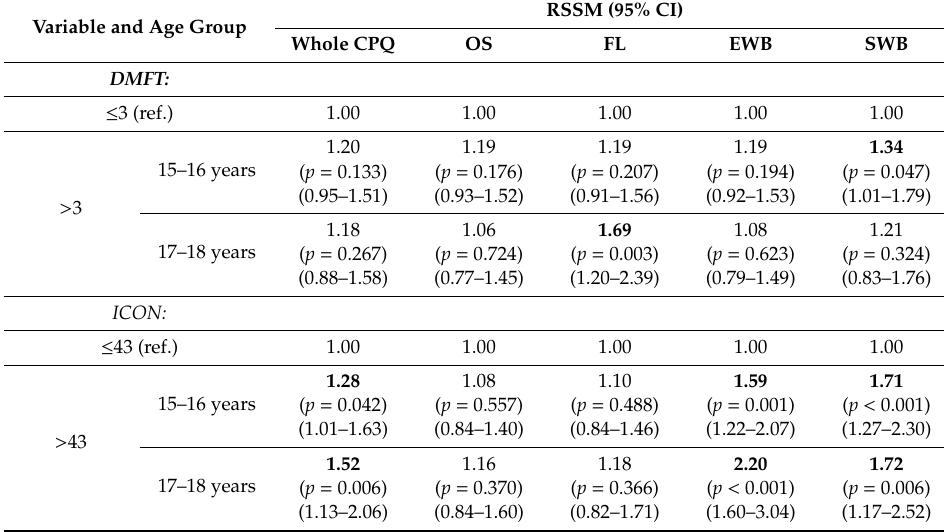
Table 5. Relationship between the clinical characteristics of oral health and the CPQ sum score by age group: results of the multivariate NBR analysis adjusting data for gender and family a ffl uence ( N =